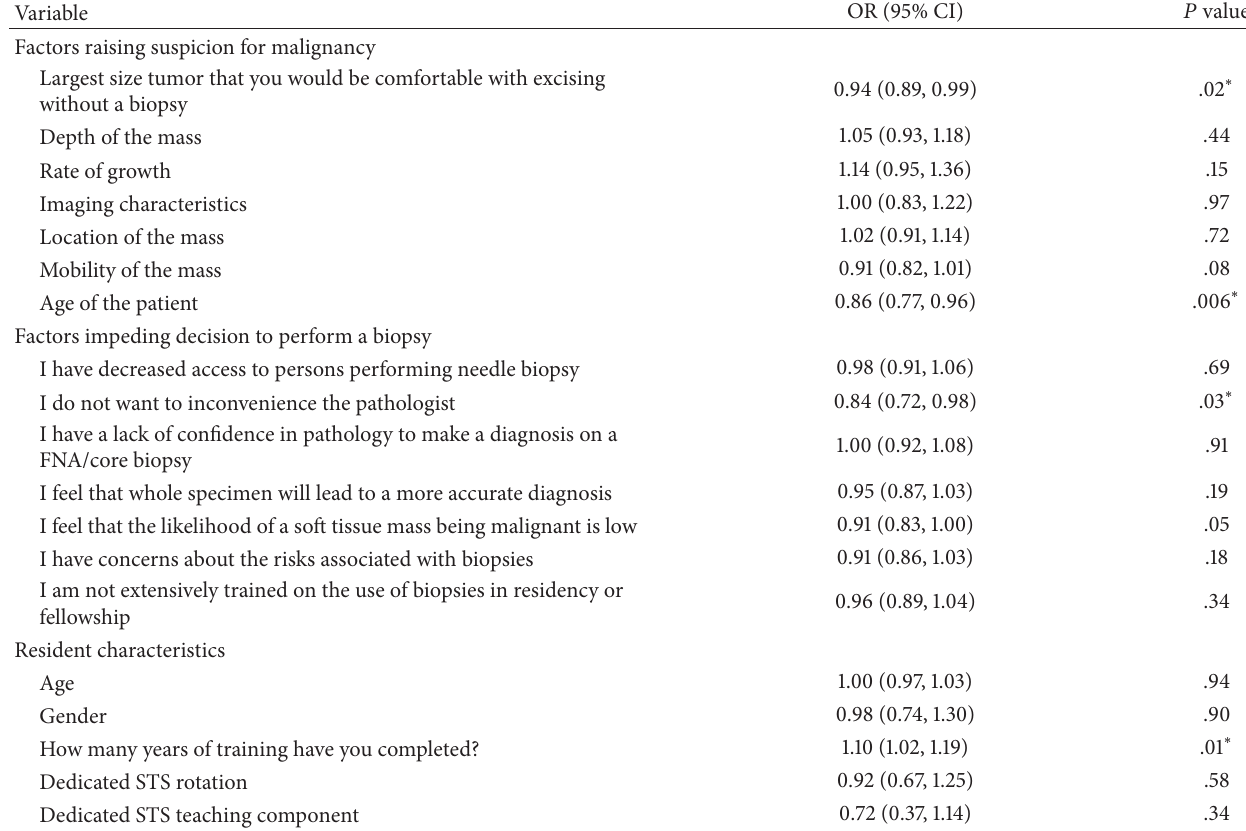
Table 6: Bivariate analyses for selecting correct clinical decision for orthopaedic surgery